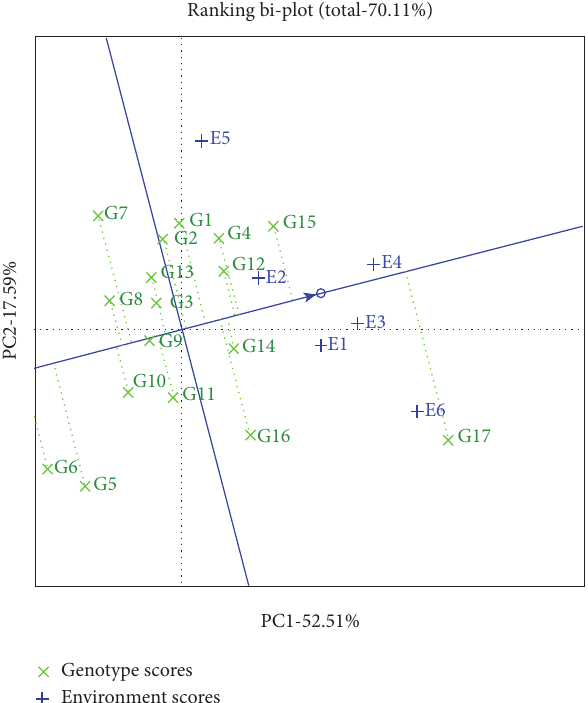
Figure 3: Average environment coordination views of the GGE biplot based on environment focused scaling for the mean per- formance and stability of genotypes. Note: E1 �